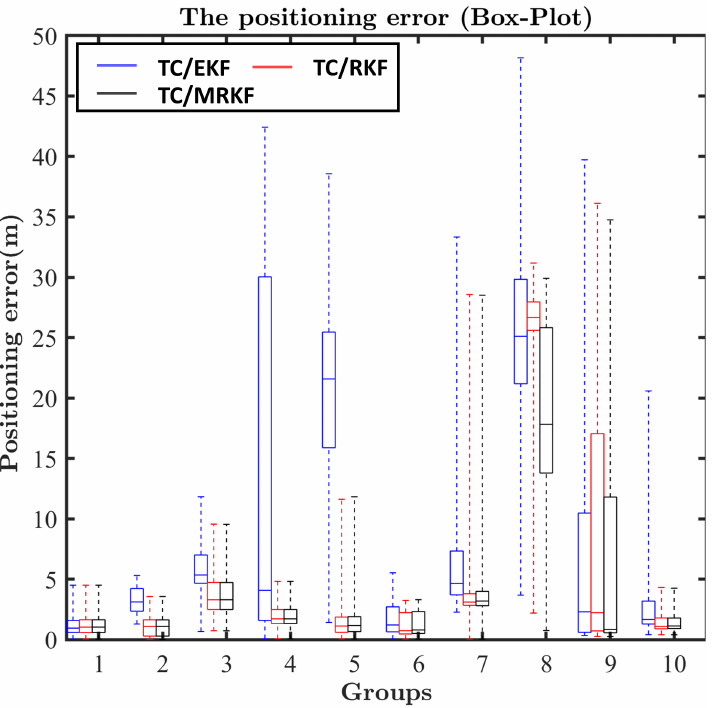
Figure 17. The box plot showing the performance of MRKF. Table 6. The positioning performance comparison between four techniques